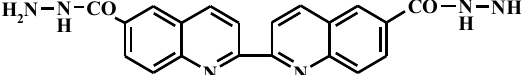
Figure 1. Structure of 2,2/-biquinoline-6,6/-dicarbohydrazide.